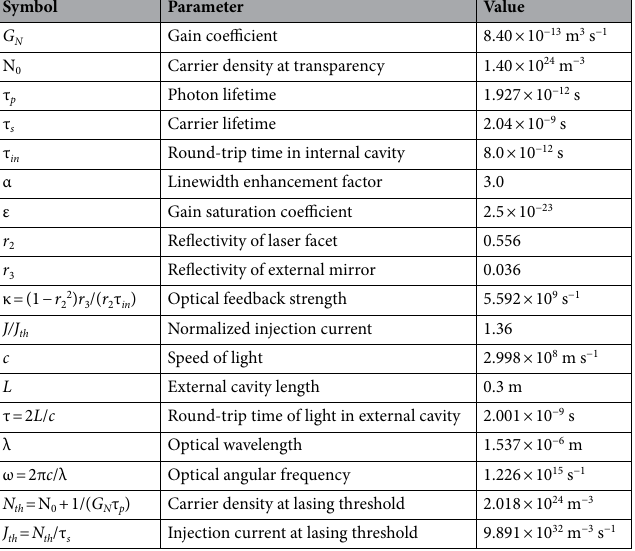
Table 1. Parameter values used in the numerical simulations of a semiconductor laser with optical